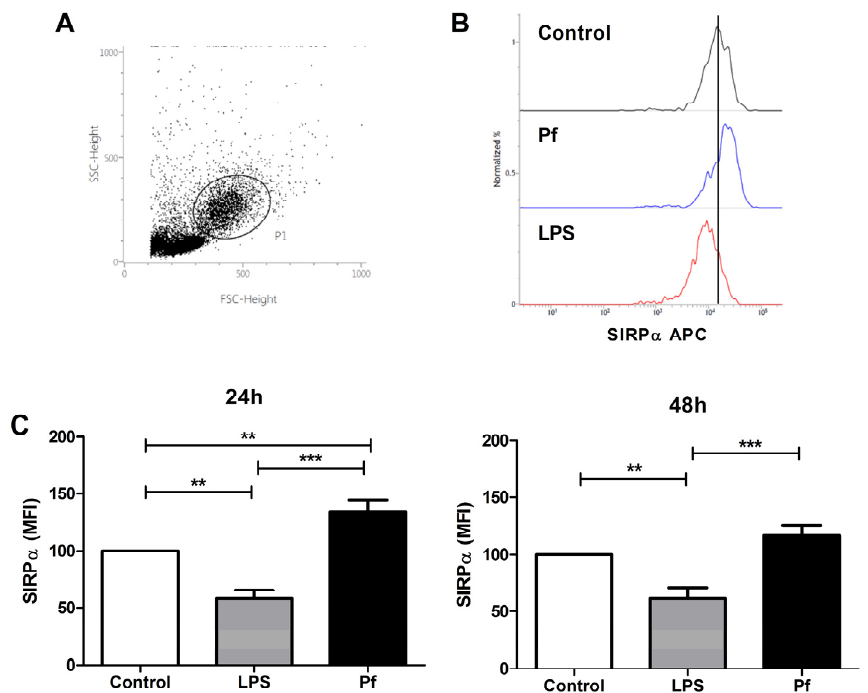
Figure 1. Modulation of SIRP α expression by P. falciparum crude extract. PBMCs from healthy individuals were stimulated for 24 and 48 h with P. falciparum extract (10 µ g/mL) or LPS (5 µ g/mL) and SIRP α expression on cell surface of monocyte-like cells was evaluated by flow cytometry using APC-conjugated anti-SIRP α monoclonal antibody. ( A , B ) Representative cytometric analysis of SIRP α expression ( B ) in gated monocyte-like cells ( A ; P1) after stimulation with P. falciparum antigens (Pf) or LPS. ( C ) Levels of SIRP α expression on monocyte-like cells population (P1), as measured by mean fluorescence intensity (MFI). Non-stimulated PBMCs were used as control (Control). Data are shown as mean ± standard error (SEM) and represent one of two independent experiments performed with PBMC samples from five individuals. **: p < 0.01; ***: p < 0.001.